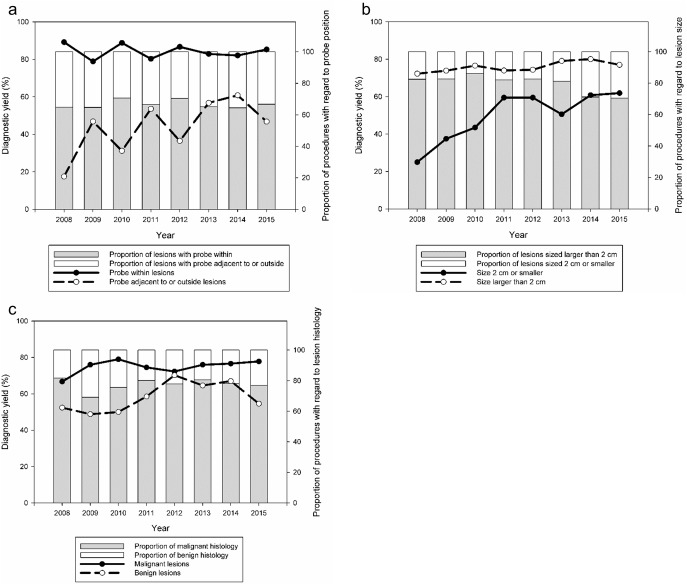
Diagnostic yield of endobronchial ultrasound-guided transbronchial biopsy and proportion of cases with regard to the probe position (a), lesion size (b) and histology (c).